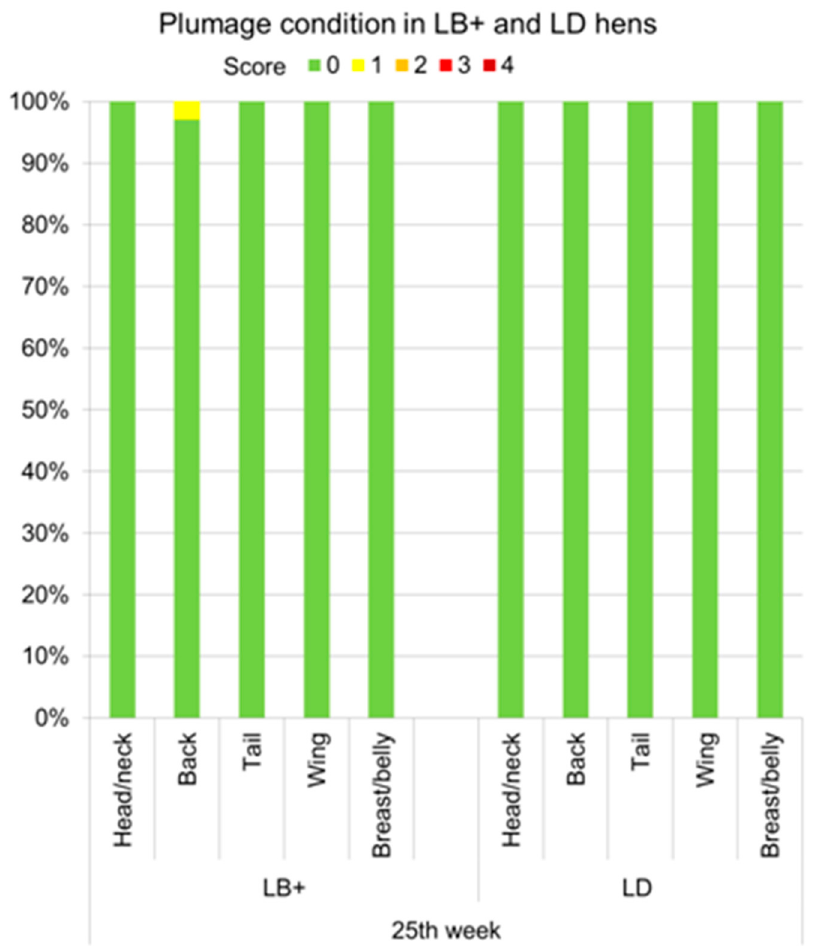
Figure 1. Proportions of Lohmann Brown plus (LB+) and Lohmann Dual (LD) hens ( n = 400) with different plumage scores (0 (best) to 4 (worst)) for head/neck, back, tail, wing and breast/belly obtained by the Visual S c oring (VSc) method in the 25th week of life.